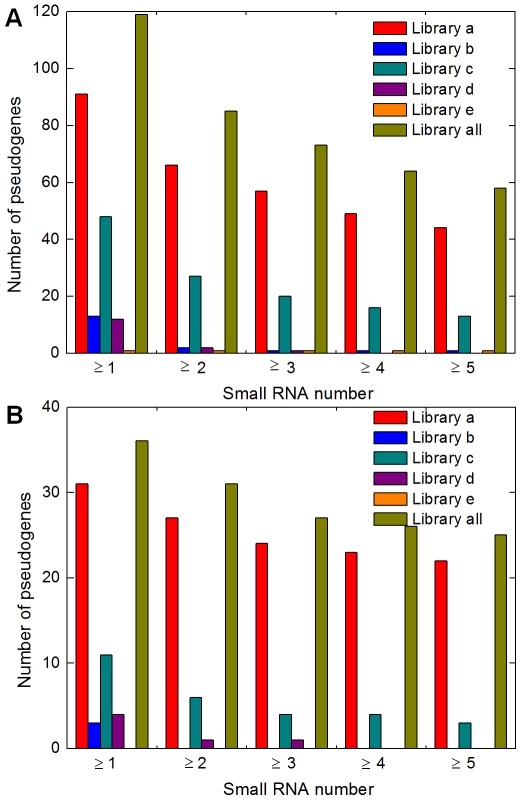
Numbers of pseudogenes with antisense small RNA in developing rice grains and five additional libraries.Here, A is for the 145 group A pseudogenes and B is for the 38 pseudogenes (group B in Figure 3) that produce siRNAs in developing rice grains. The x-axes represent the numbers of siRNAs from the other five libraries. Information for the libraries a–e is described below. Library all is the union of a to e. a. Dehulled mature grain, 141,370 small RNAs (matching uniquely to rice genome, ditto below). Heisel et al., 2008 [53]; b. 23 days old seedlings, 58,863 small RNAs. Heisel et al., 2008 [53]; c. A mixture of RNAs by MPSS from (1) seedlings treated with ABA, (2) nipponbare immature panicles - 90 days old plants, (3) germinating seedlings infected with Magnaporthe grisea, (4) germinating seedlings, (5) stem, and (6) seedling control for ABA treatment. 136,870 small RNAs. Nobuta et al., 2007 [54]; d. Four-week old seedlings, 73,174 small RNAs. Zhou et al., 2008 ; e. CRSDB, a mixture of RNAs isolated from 30 to 60 day leaves (∼16.5%), 10, 25 and 30 day seedlings (∼11%), 4–7 cm inflorescences (∼16.5%) and 25 day seedling polysomes (∼16.5%), 5,521 small RNAs. Johnson et al., 2006 [55].